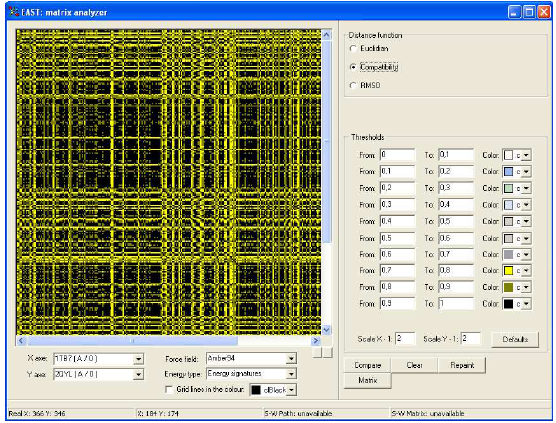
Fig. 14. EAST: matrix analyzer window showing sample compatibility degree matrix for specified